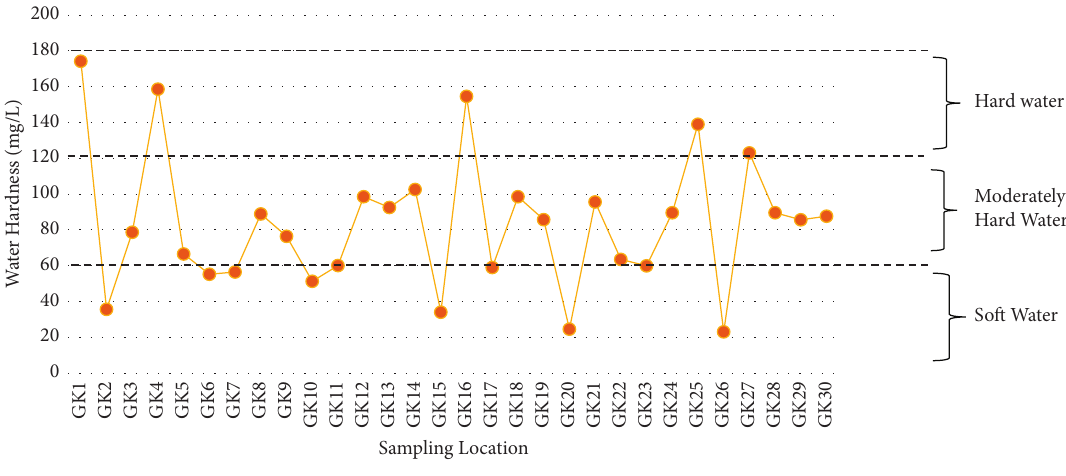
Figure 4: Total water hardness in drinking water samples collected from Girandurukotte GND, Badulla district, Sri Lanka. All data were presented as the mean of three replicates